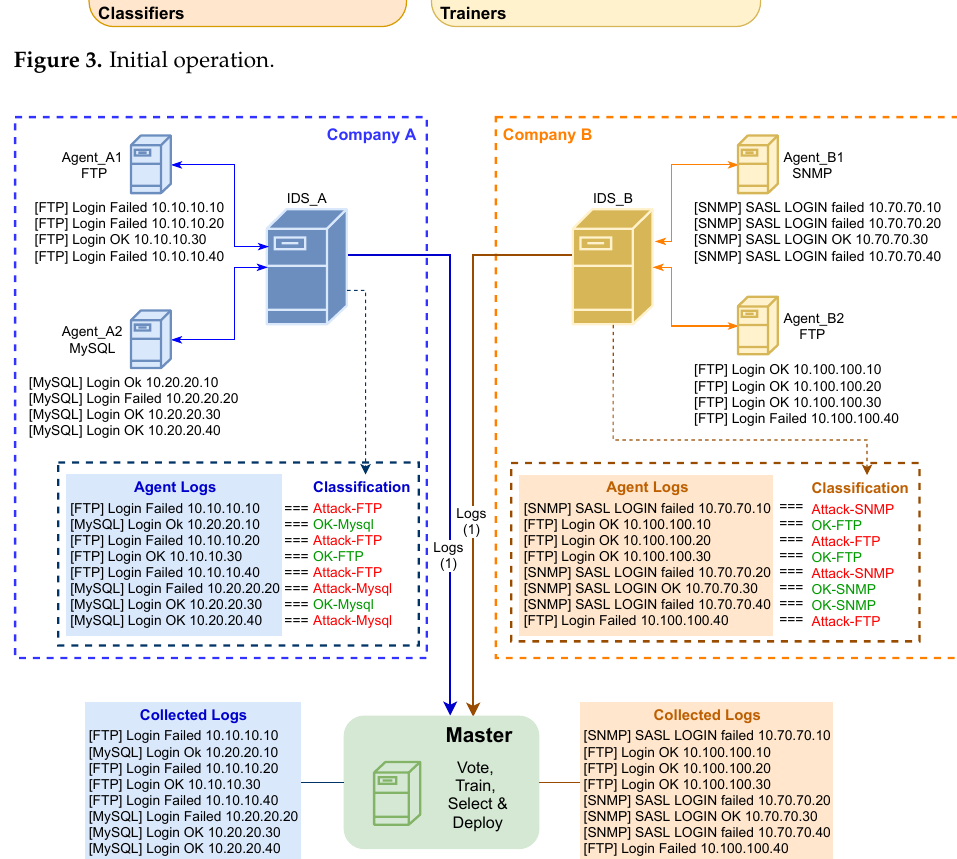
Figure 4. Unclassified logs collection from companies’